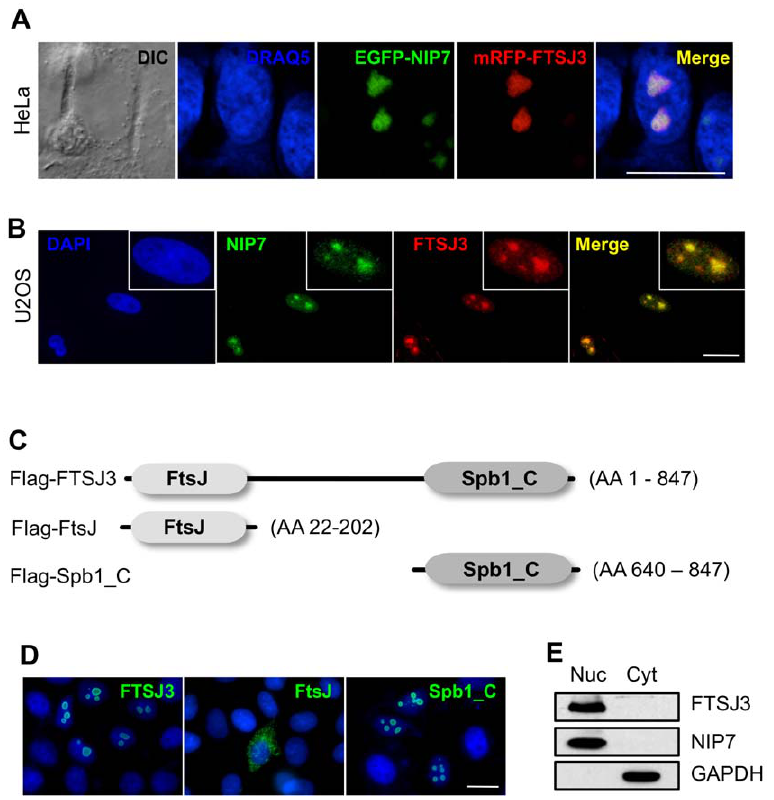
Figure 3. FTSJ3 colocalizes with NIP7 in the nucleolus. ( A ) Transient expression of EGFP-NIP7 and mRFP-FTSJ3 in HeLa cells. Both fusion proteins are observed in the nucleolus 48 hours post transfection. Nuclei were counterstained in blue with DRAQ5. ( B ) Immunofluorescent localization of endogenous NIP7 and FTSJ3 in U2OS cells. NIP7 and FTSJ3 were detected using secondary antibodies conjugated to Alexa Fluor 488 (green) and 568 (red), respectively. Nuclei were counterstained with DAPI. Boxes show an enlarged nucleus ( C ) Diagram of the FTSJ3 protein indicating the two conserved domains, FtsJ and Spb1_C (adapted from PFAM data base). ( D ) Subcellular localization of FLAG-tagged FTSJ3 and FtsJ and Spb1_C domains in transiently transfected HeLa cells. The FLAG-tagged proteins were immunostained with anti-FLAG followed by FITC- conjugated secondary IgG. Nuclei were counterstained with DAPI. The panel shows overlays of DAPI counterstaining and immunostaining. Scale bars represent 30 m m. ( E ) Western blots of HeLa nuclear (Nuc) and cytoplasmic (Cyt) preparations showing FTSJ3 in the nuclear fraction. NIP7 and GAPDH were used as controls for nuclear and cytoplasmic fractions, respectively.